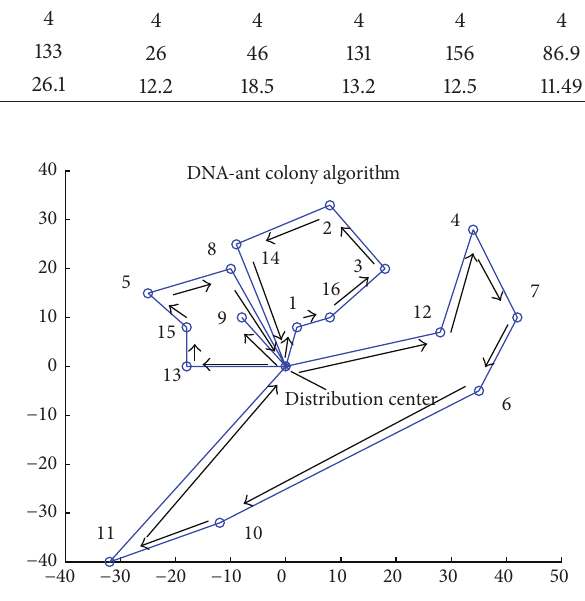
Figure 8: Distribution path basic ant colony algorithm (moderate or high level pollution).